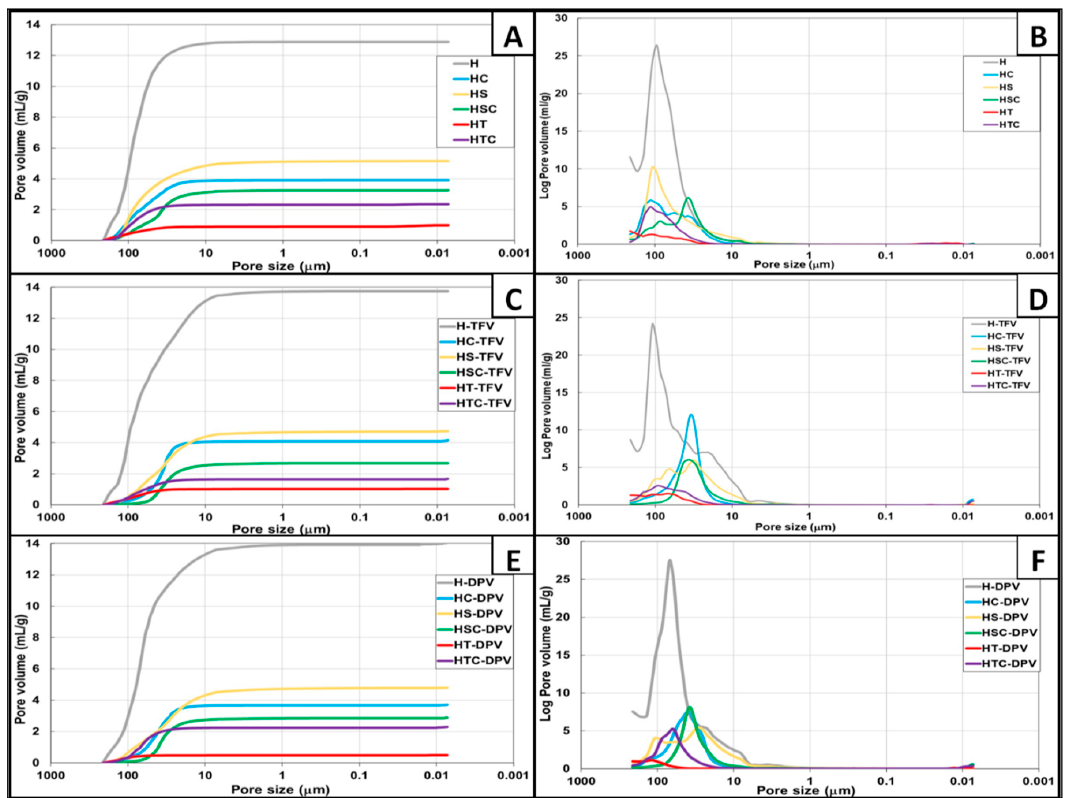
Figure 5. Pore size distributions of vaginal discs, presented as the cumulative volume of unloaded ( A ), TFV ( C ), and DPV ( E ) batches and the logarithm of the differential pore volume of unloaded ( B ), TFV ( D ), and DPV ( F ) batches.